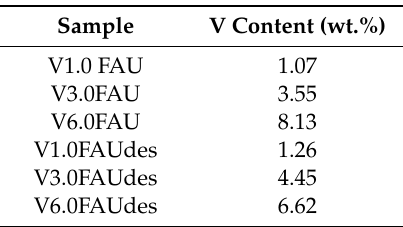
Table 2 gathers data obtained from the porosimetric